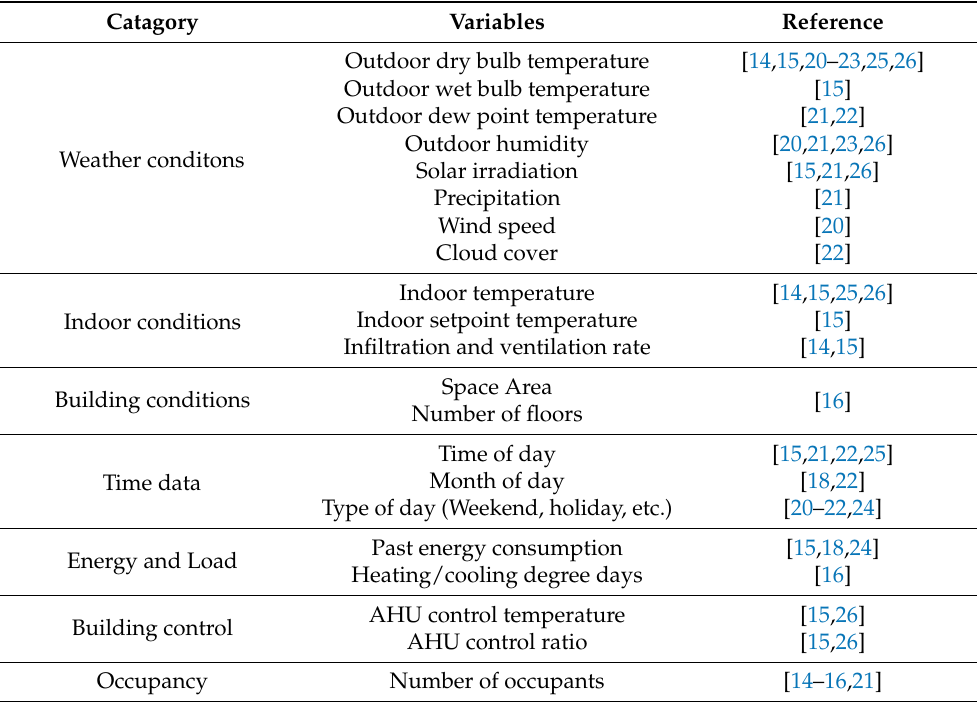
Table 1. The significant variables utilized in previous